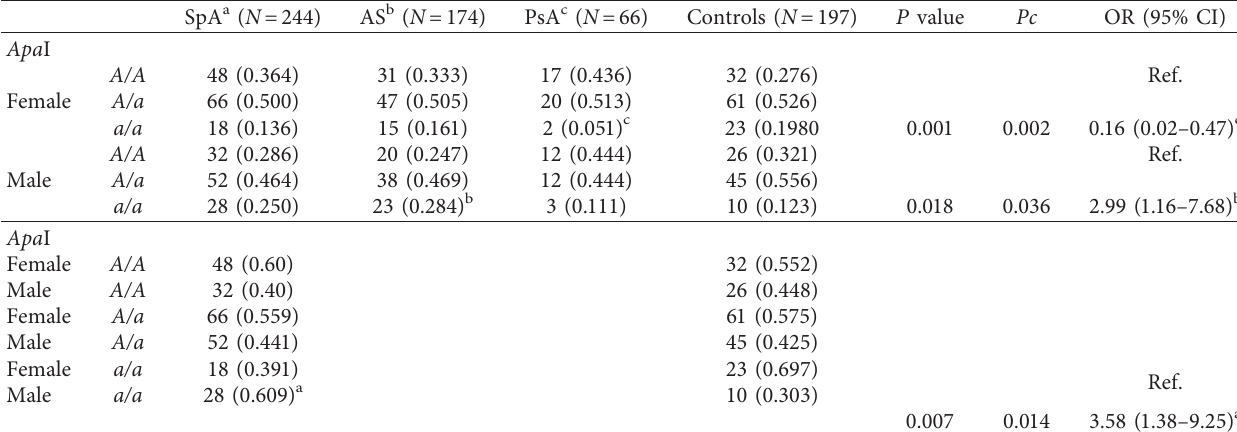
Table 4: Association between Apa I and spondyloarthritis (SpA), ankylosing spondylitis (AS), and psoriatic arthritis (PsA) within and between